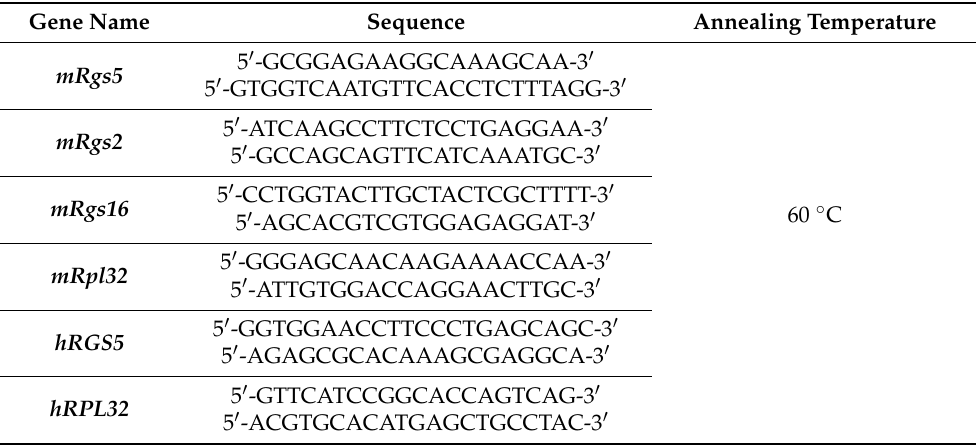
Table 1. PCR primer